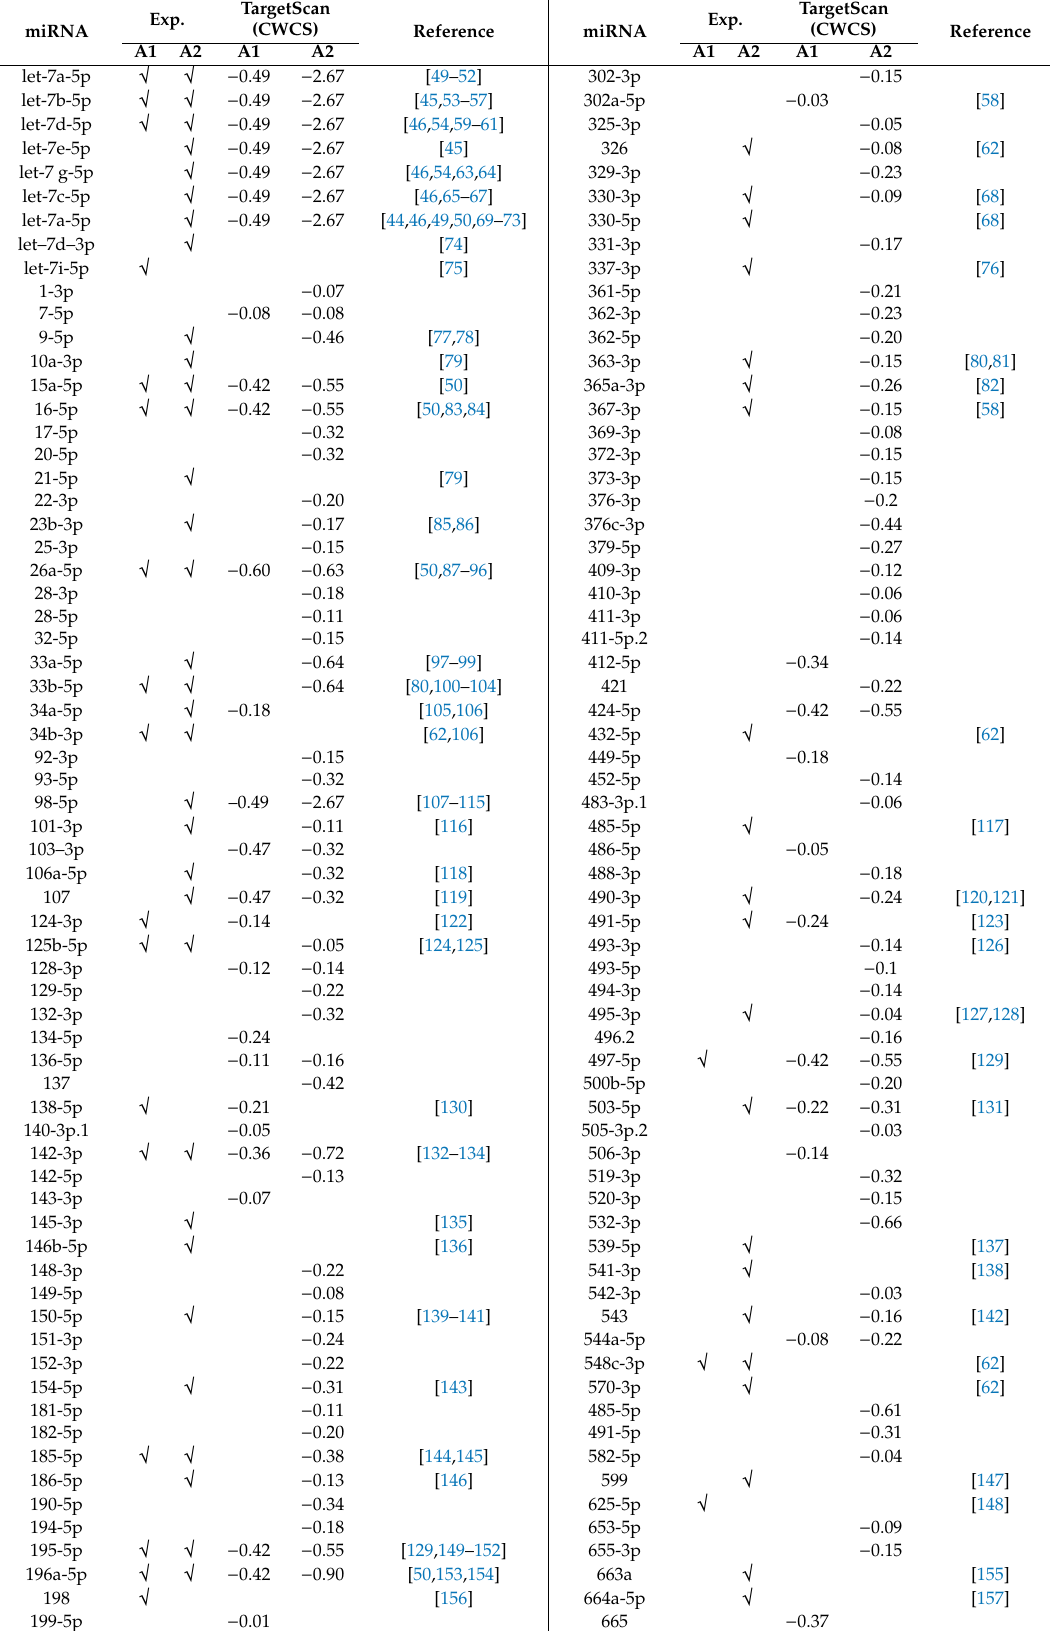
Table 1. High mobility group A 1 (HMGA1)- and HMGA2-targeting of microRNAs (miRNAs). miRNA